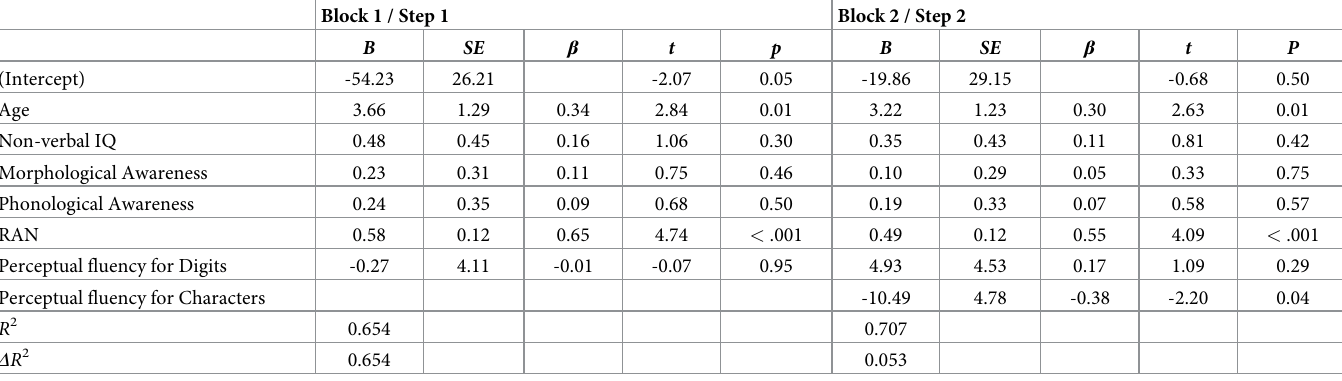
Table 3. Results of the hierarchical regression analysis for variables predicting speeded